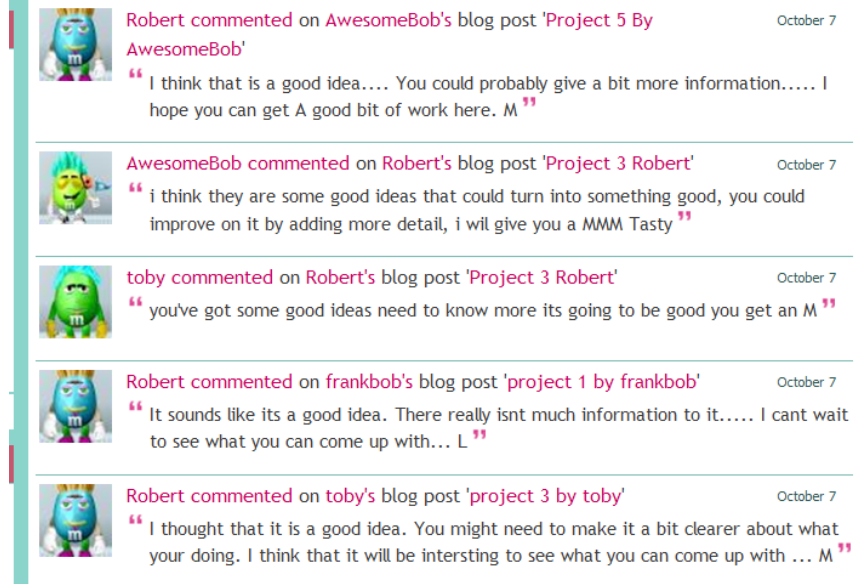
Figure 8. Examples of individual peer feedback and